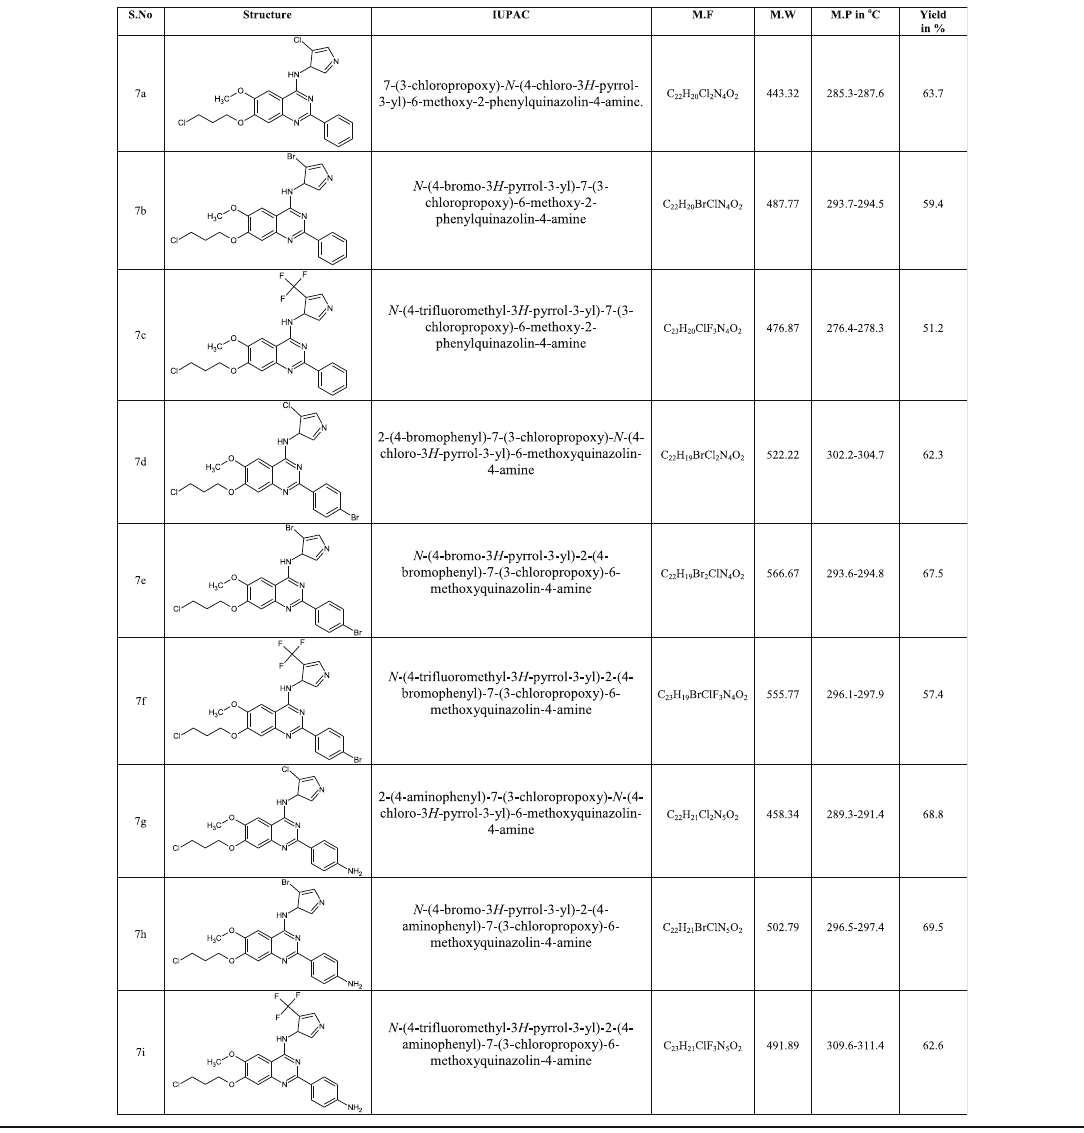
Table 2 Synthesized quinazoline – pyrrole hybrid